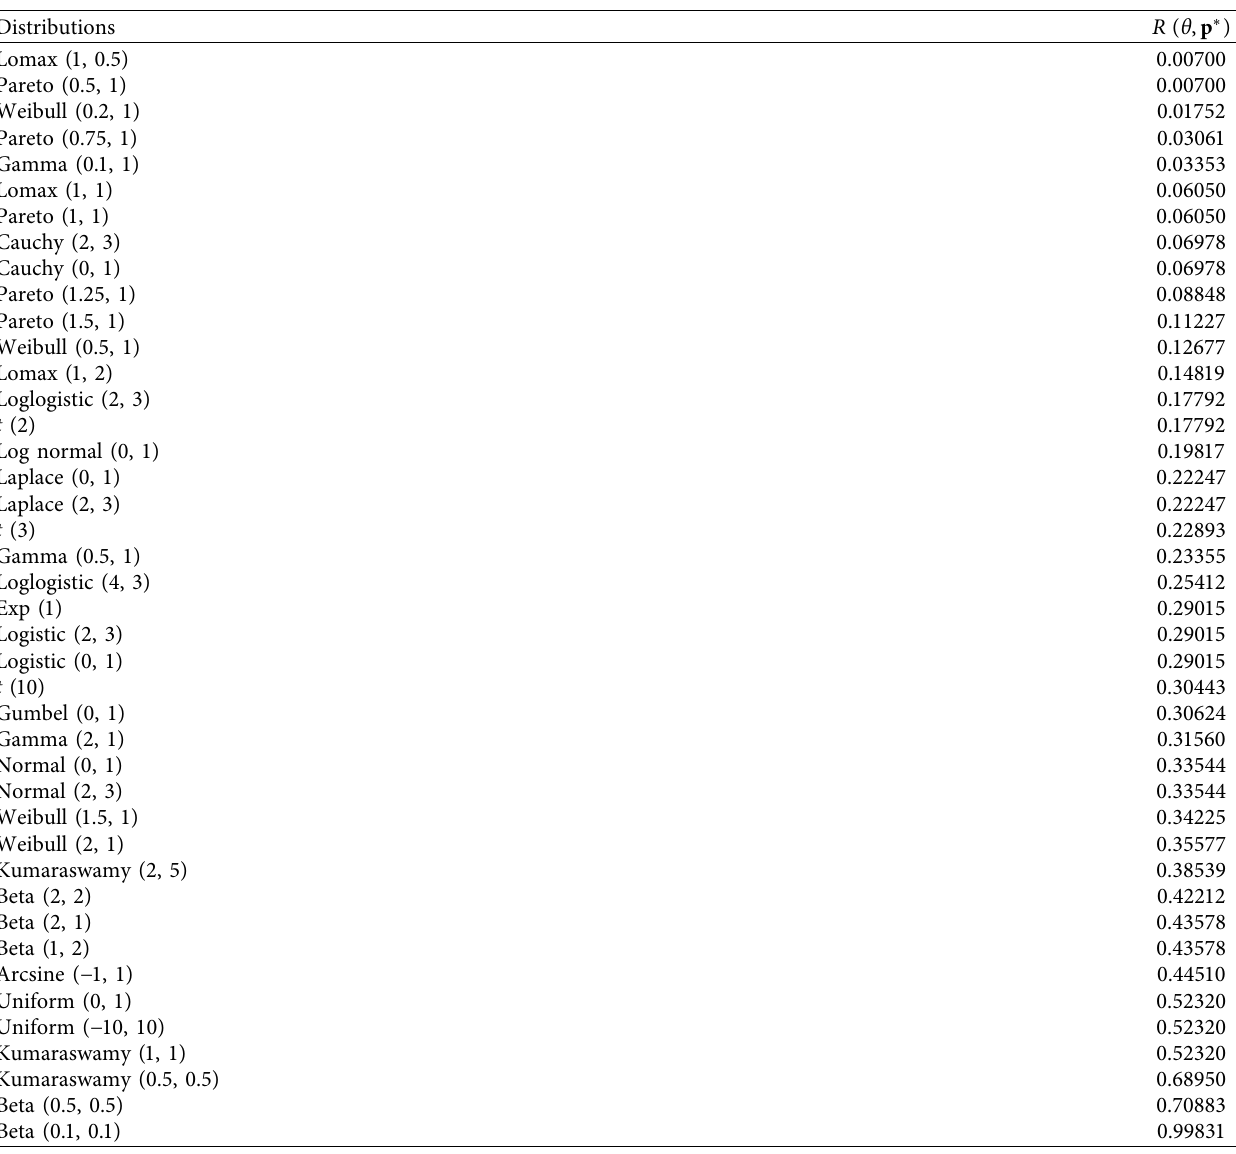
Table 1: Some values of index R ( θ , p ∗ ) for several